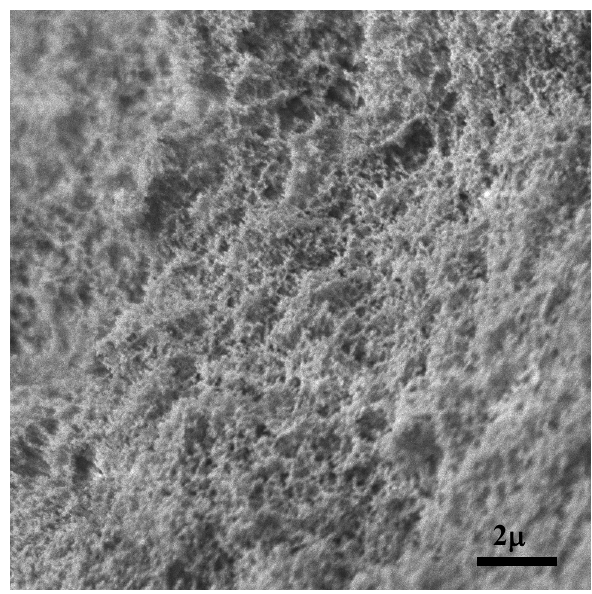
Figure 4. SEM image of WEAX